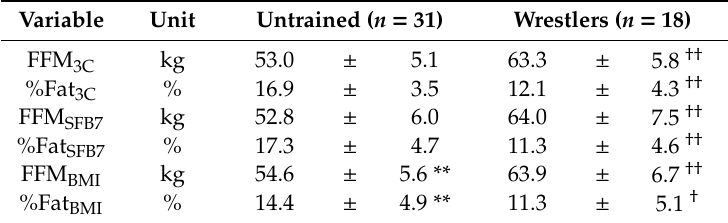
Table 3. Body composition estimated from total body water (TBW) measured using the D 2 O dilution technique and bioimpedance spectroscopy